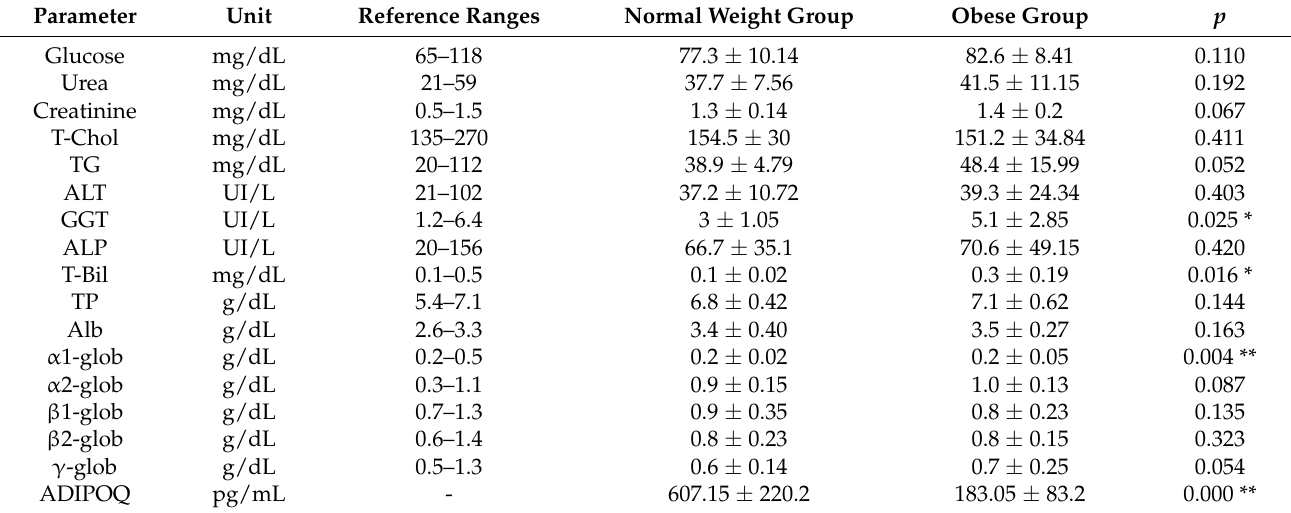
Table 2. Serum biochemical analysis and serum ADIPOQ profile in obese and normal weight dogs.